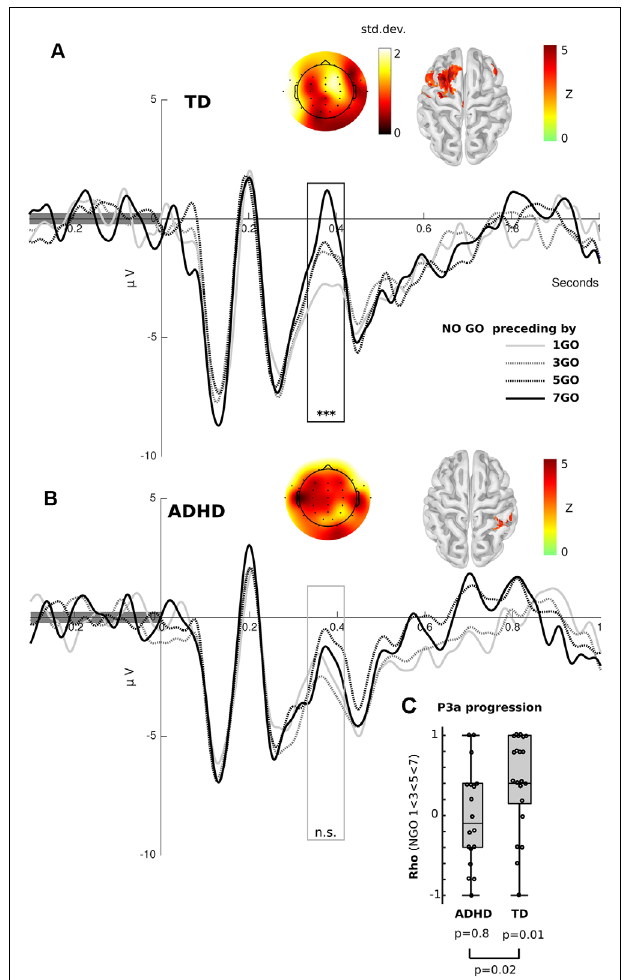
FIGURE 2 | Event-related potential (ERP) results. (A) Frontal ERP elicited by Nogo stimuli separated by the number of preceding Go trials in TD children. The black box shows the significant differences between conditions [Kruskal–Wallis and Cluster-based Permutation (CBP) test, p < 0.01]. (B) Frontal ERP elicited by Nogo stimuli separated by the number of preceding Go trials in ADHD children. The gray box represents the P3a, where significant differences were found for the TD group, but not for the ADHD children (Kruskal–Wallis, p > 0.05, uncorrected). (A,B) Color in the scalp plot represents the standard deviation between conditions. In the cortex surface (source space), the Z -value of the difference among conditions is plotted. (C) Box plot of the spearman rho value of the correlation between P3a peak (FCz electrode) and the number of preceding Go stimuli per subject, separated by group. ∗∗∗ p < 0.001, n.s. = p >